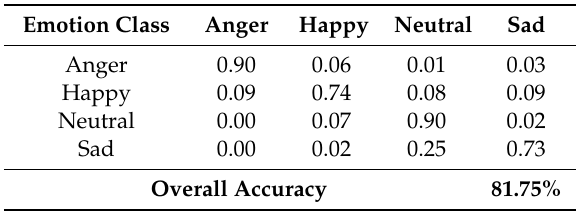
Table 4. Confusion matrix for emotions prediction on IEMOCAM with average recall value (81.75%) and each row indicated the confusion of each emotion with ground truth and